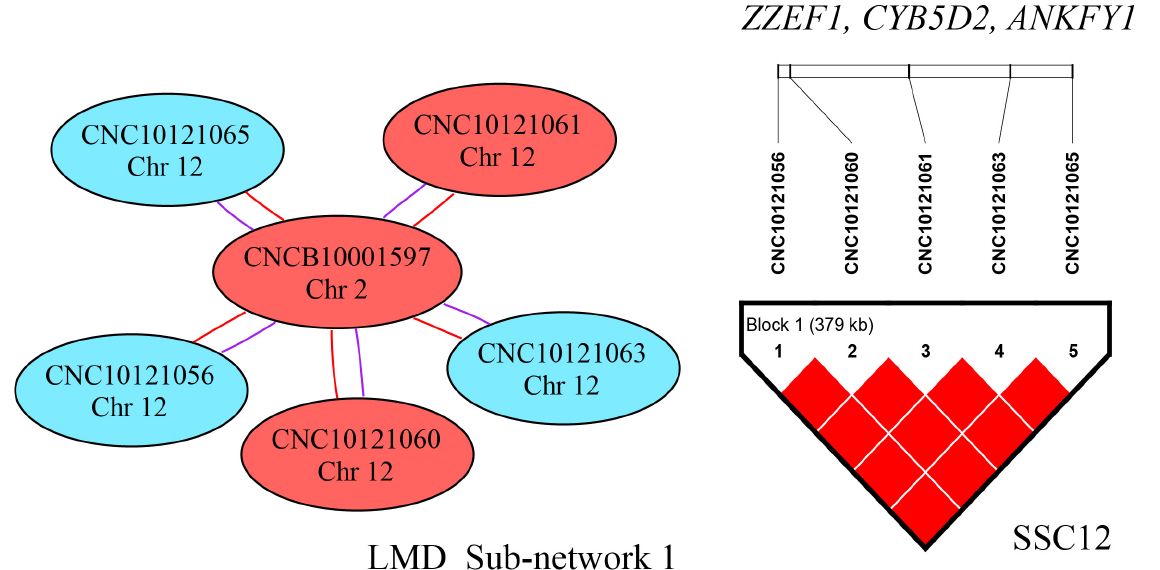
Figure 5. Epistatic sub-network 1 among SNPs affecting LMD and the related LD information. The color of a node represents the p -value of an interaction ( p < 1 × 10 − 12 = red; p < 1 × 10 − 11 = blue; p < 1 × 10 − 10 = green). The color of connecting lines between circles indicates the type of epistatic effect (A × A = red; A × D = purple; D × D = green). The genes located in the LD regions are